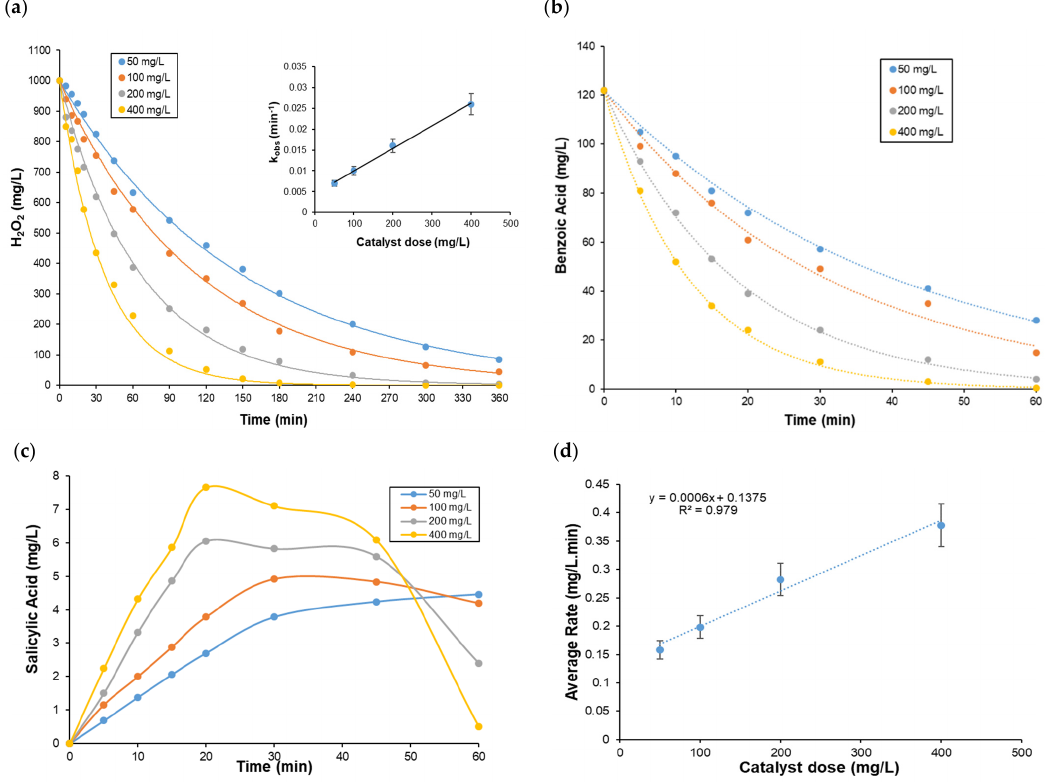
Figure 2. ( a ) Kinetics of the decomposition of H 2 O 2 (1000 mg/L) with a Fe-based catalyst. Inlet: Increase of pseudo-first order rate constant with catalyst dose (50–400 mg/L, (particle size < 200 µm); ( b ) Degradation of benzoic acid, (exponential trend lines are added to graphs a and b); ( c ) Formation of salicylic acid, and ( d ) Dependence of the average rate of formation of salicylic acid on the catalyst dose during the degradation of benzoic acid (122 mg/L) using a H 2 O 2 (1000 mg/L)/Fe-based catalyst (50–400 mg/L, particle size < 200 µm) system. Experimental conditions: pH = 3.0, Temperature: 23– 25 °C, Mixing rate: 400 rpm.